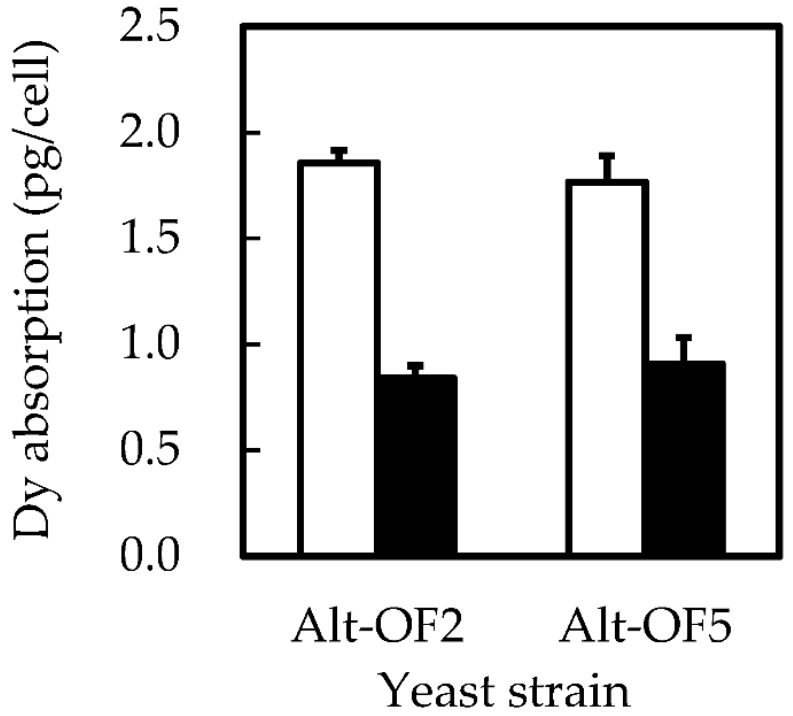
Figure 4. Dy absorption in the heat-killed cells of Alt-OF2 and Alt-OF5. Yeast cells (Alt-OF2 and Alt-OF5) were treated at 60 °C and then treated with 0.1 g/L of Dy acetate at pH 6.0 for 2 h. White and black columns represent untreated and heat-treated cells, respectively.